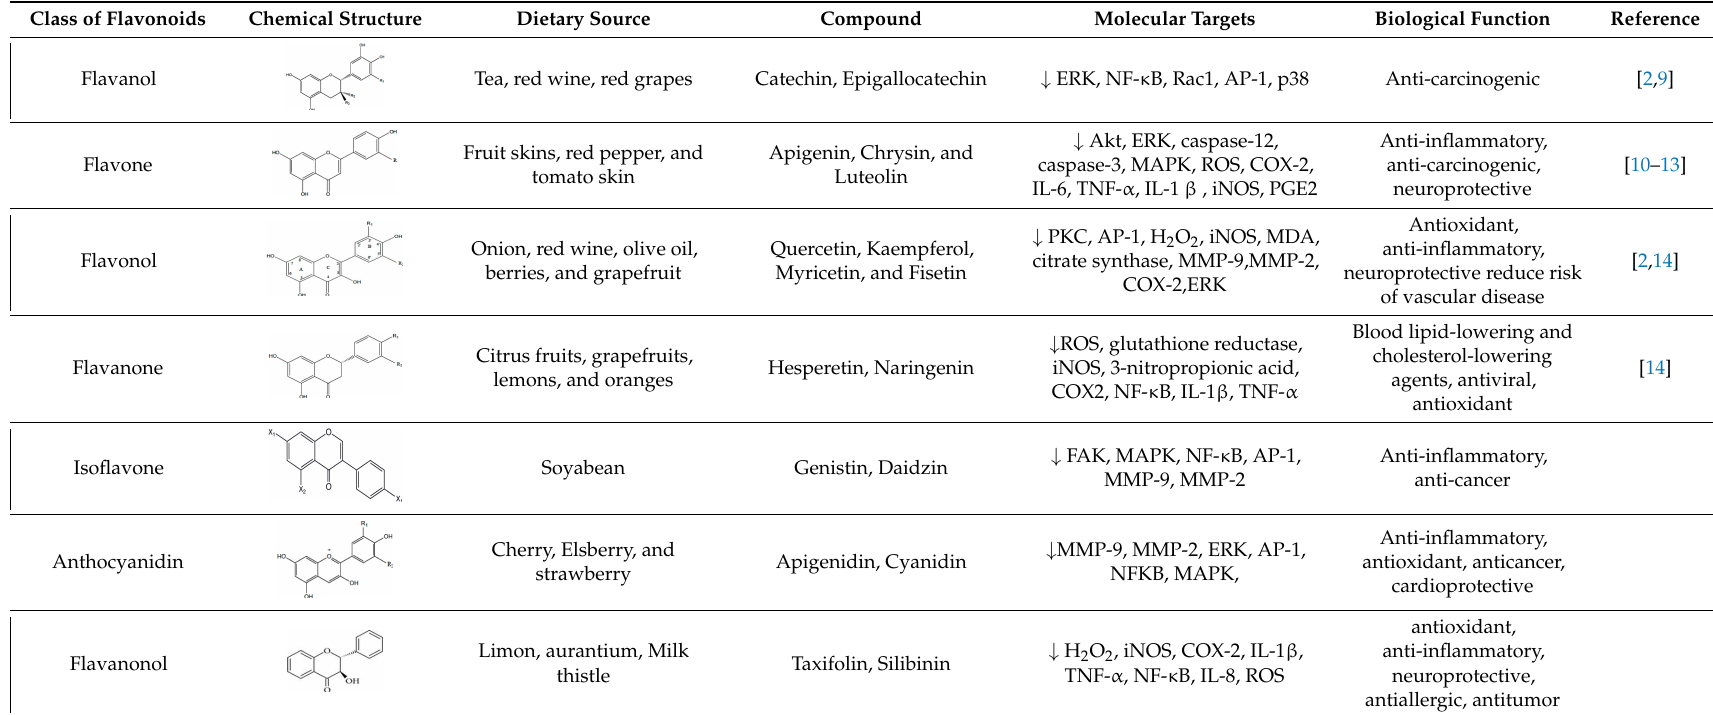
Table 1. Subclasses of flavonoids. ERK—extracellular signal-regulated kinases, NF- κ B—nuclear factor-kappa B; MAPK—mitogen-activated protein kinase; ROS—reactive oxygen species; COX-2—cyclooxygenase-2; IL—interleukin; TNF—tumor necrosis factor; iNOS—inducible NO synthase; PKC—protein kinase C, MDA—malondialdehyde , MMP—matrix metalloproteinase, FAK—focal adhesion